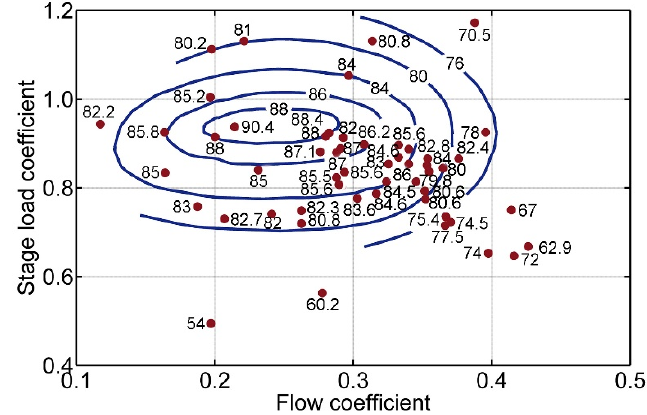
Figure 2. The loading-to-flow diagram [13].